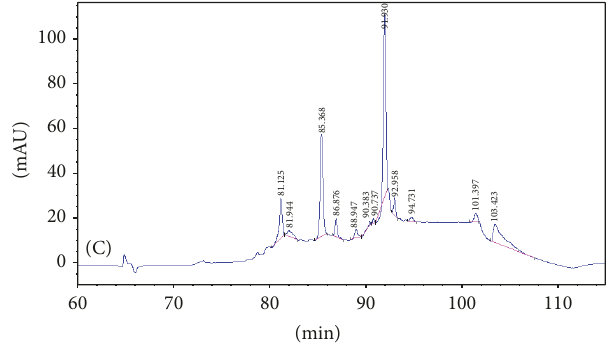
Figure 1: The peaks of peptides in the serum of 3 groups. (A) Blank- control group, (B) restrained group, and (C) asthma model group.